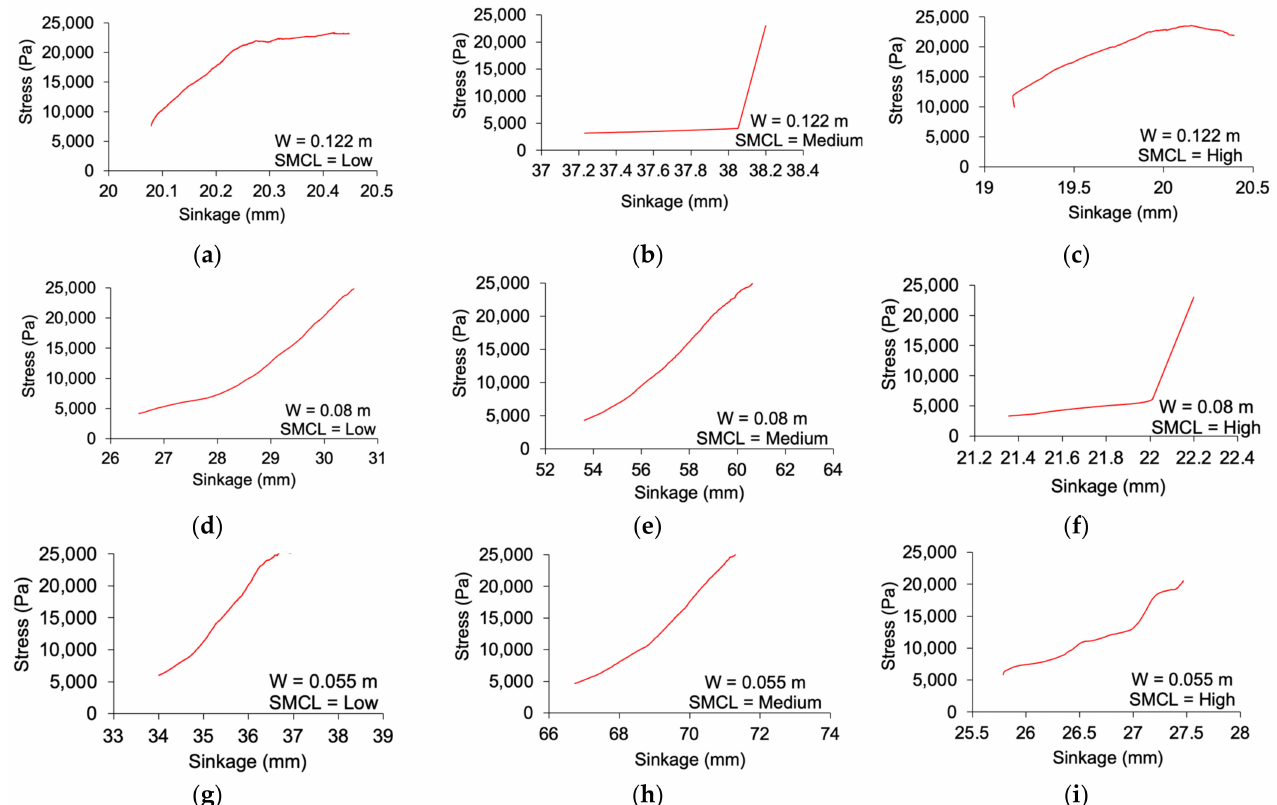
Figure 7. Press-wheel width (W) effects on the stress–sinkage relationship for the three soil moisture content levels (SMCL) using data from first measuring sphere (MS-1): ( a – c ) Stress-sinkage relationship for 0.122 m press-wheel width across three soil moisture content levels; ( d – f ) Stress-sinkage relationship for 0.08 m press-wheel width across three soil moisture content levels; ( g – i ) Stress-sinkage relationship for 0.055 m press-wheel width across three soil moisture content